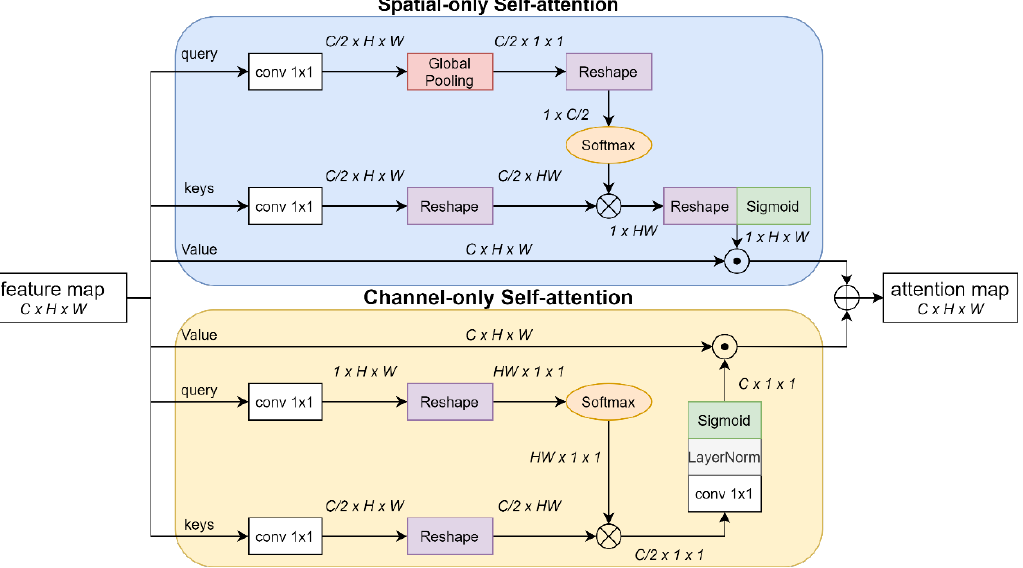
Figure 7. The architecture of the polarized self-attention (PSA) module. The input feature is sent to the spatial-wise attention and channel-wise attention parallelly, to make it more discriminative for a complex environment.